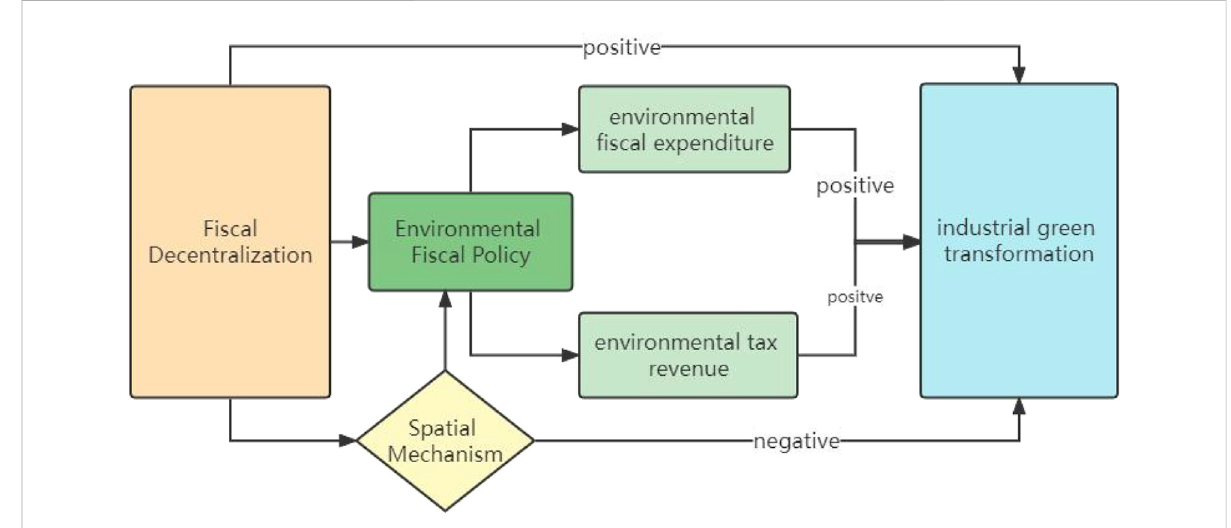
FIGURE 2 The theoretical model of